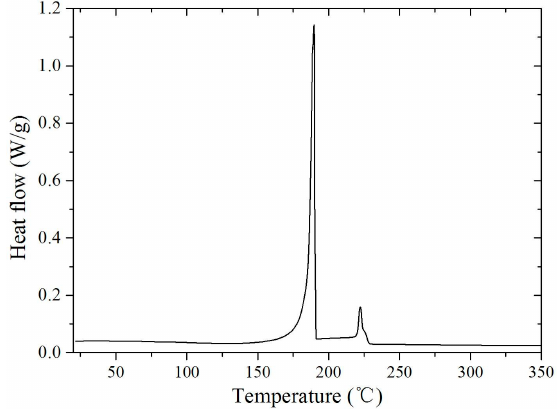
Figure 1. DSC curve of the ternary Sn-12Zn-6Bi alloy upon cooling.